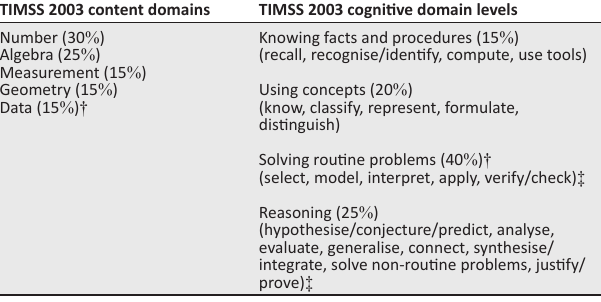
TABLE 1: Content and cognitive domains for mathematics used in TIMSS 2003.